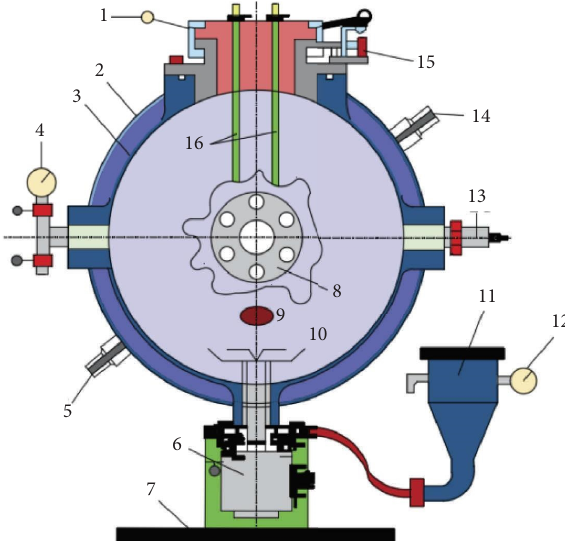
Figure 1: Structure diagram of explosion-pressure testing equipment. (1) sealing cap; (2) outer side of mezzanine; (3) inside of mezzanine; (4) vacuum gauge; (5) outlet of water; (6)